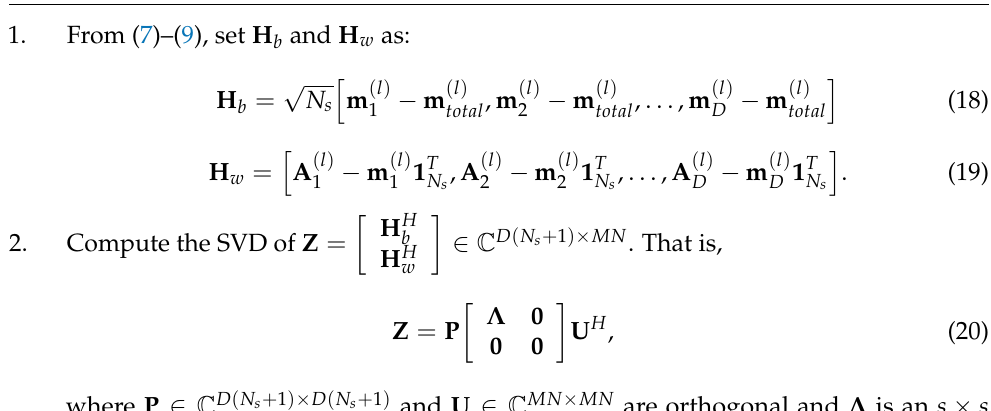
Algorithm 1 LDA/GSVD algorithm for motion